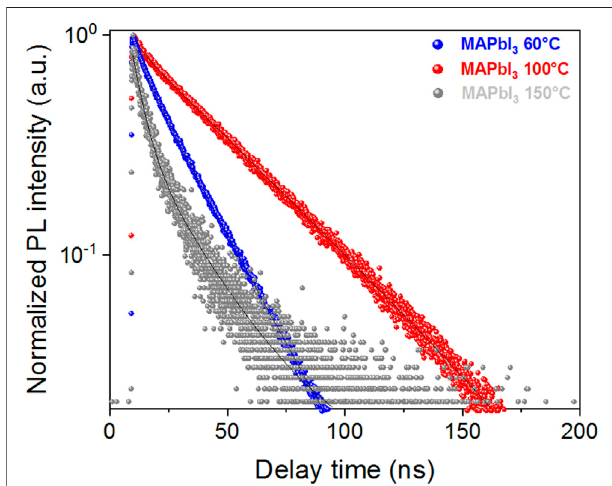
FIGURE 4 | Evolution of PL decay measured by Time-Correlated Single Photon Counting (TCSPC) technique using 475 nm excitation (2 MHz,